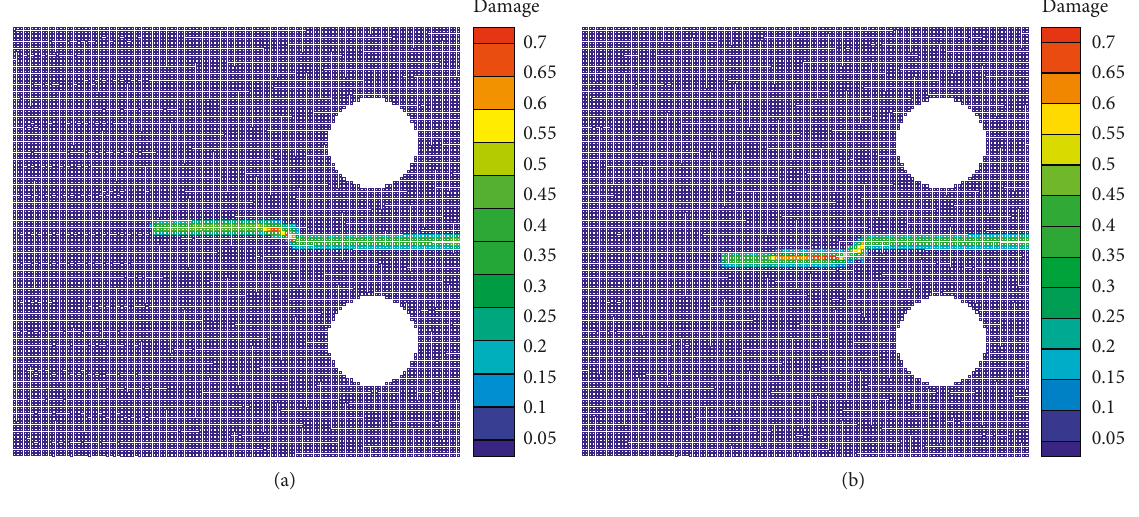
Figure 14: Fatigue crack paths for (a) sample 3 and (b) sample